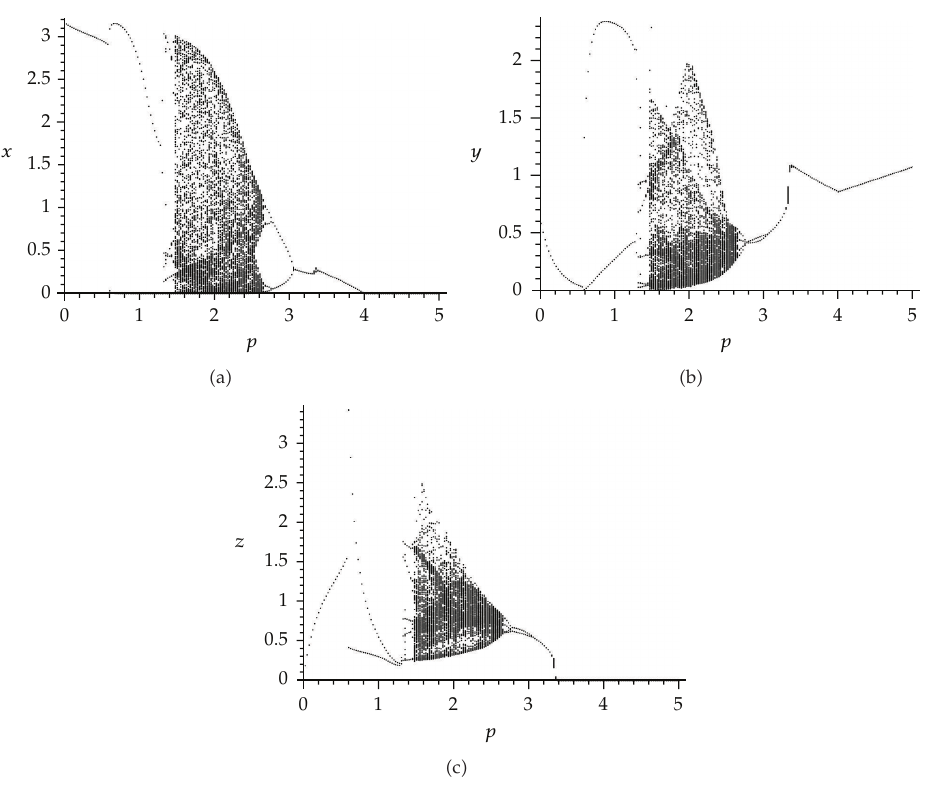
Figure 3: Bifurcation diagram of system (cid:5) 1.3 (cid:6) with initial conditions x (cid:5) 0 (cid:6) (cid:7) 0 . 1, y (cid:5) 0 (cid:6) (cid:7) 0 . 1, z (cid:5) 0 (cid:6) (cid:7) 0 . 1, and 0 ≤ p ≤ 5; a (cid:7) 1 . 72, b (cid:7) 0 . 52, c 1 (cid:7) 0 . 83, c 2 (cid:7) 0 . 64, c 3 (cid:7) 0 . 23, c 4 (cid:7) 0 . 32, c 5 (cid:7) 0 . 76, c 6 (cid:7) 0 . 48, e 1 (cid:7) 0 . 56, e 2 (cid:7) 0 . 62, d 1 (cid:7) 0 . 12, d 2 (cid:7) 0 . 25, T (cid:7) 13, and q (cid:7) 0 .